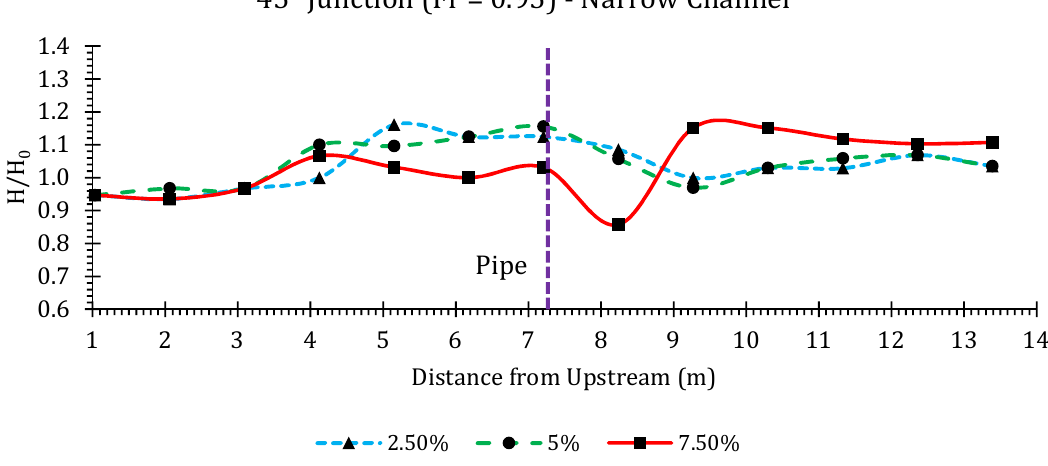
Figure A26. Water height ratios in a 45 ◦ junction for Fr = 0.95 in the narrow Figure A26. Water height ratios in a 45° junction for Fr = 0.95 in the narrow channel. Figure A26. Water height ratios in a 45° junction for Fr = 0.95 in the narrow channel. Figure A26. Water height ratios in a 45° junction for Fr = 0.95 in the narrow channel.